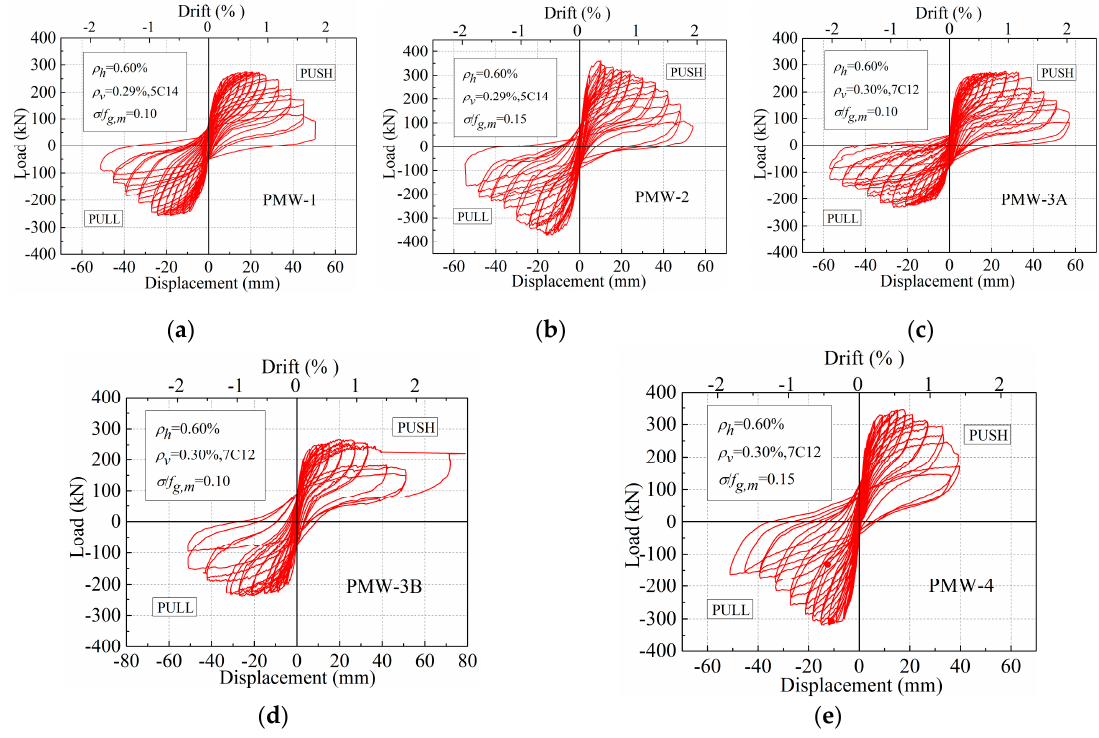
Figure 7. Force–displacement hysteresis curves of the tested walls: ( a ) PMW-1; ( b ) PMW-2; ( c ) PMW-3A; ( d ) PMW-3B; and ( e ) PMW-4.